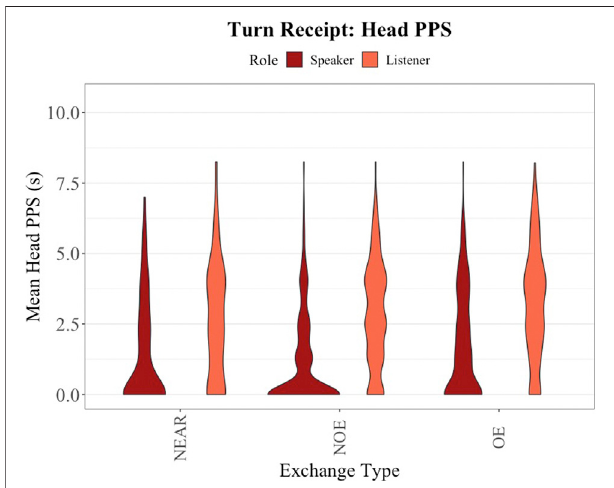
FIGURE 9 | Turn Receipt Head PPS summary by exchange type and role.